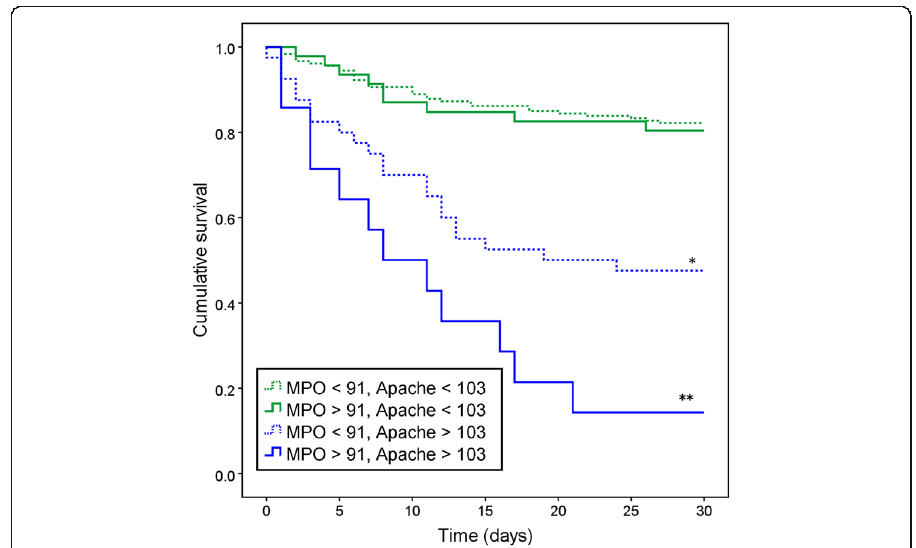
Fig. 3 Kaplan Meier 30-day survival curve. MPO myeloperoxidase, APACHE Acute Physiology And Chronic Health Evaluation. Single asterisk indicates significant difference with upper lines ( P > 0.001), and double asterisks indicate significant difference with third line ( P = 0.028)